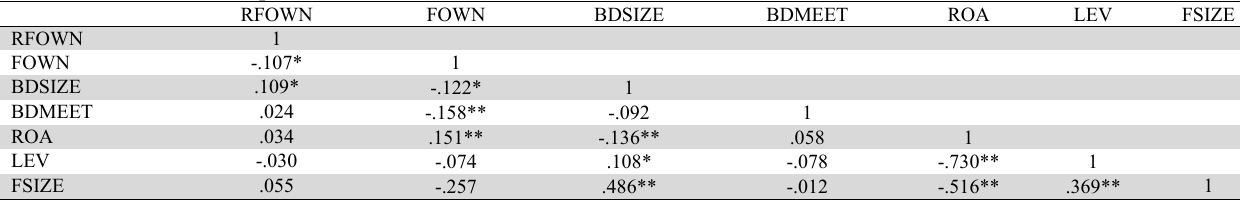
Correlation matrix of independent variables